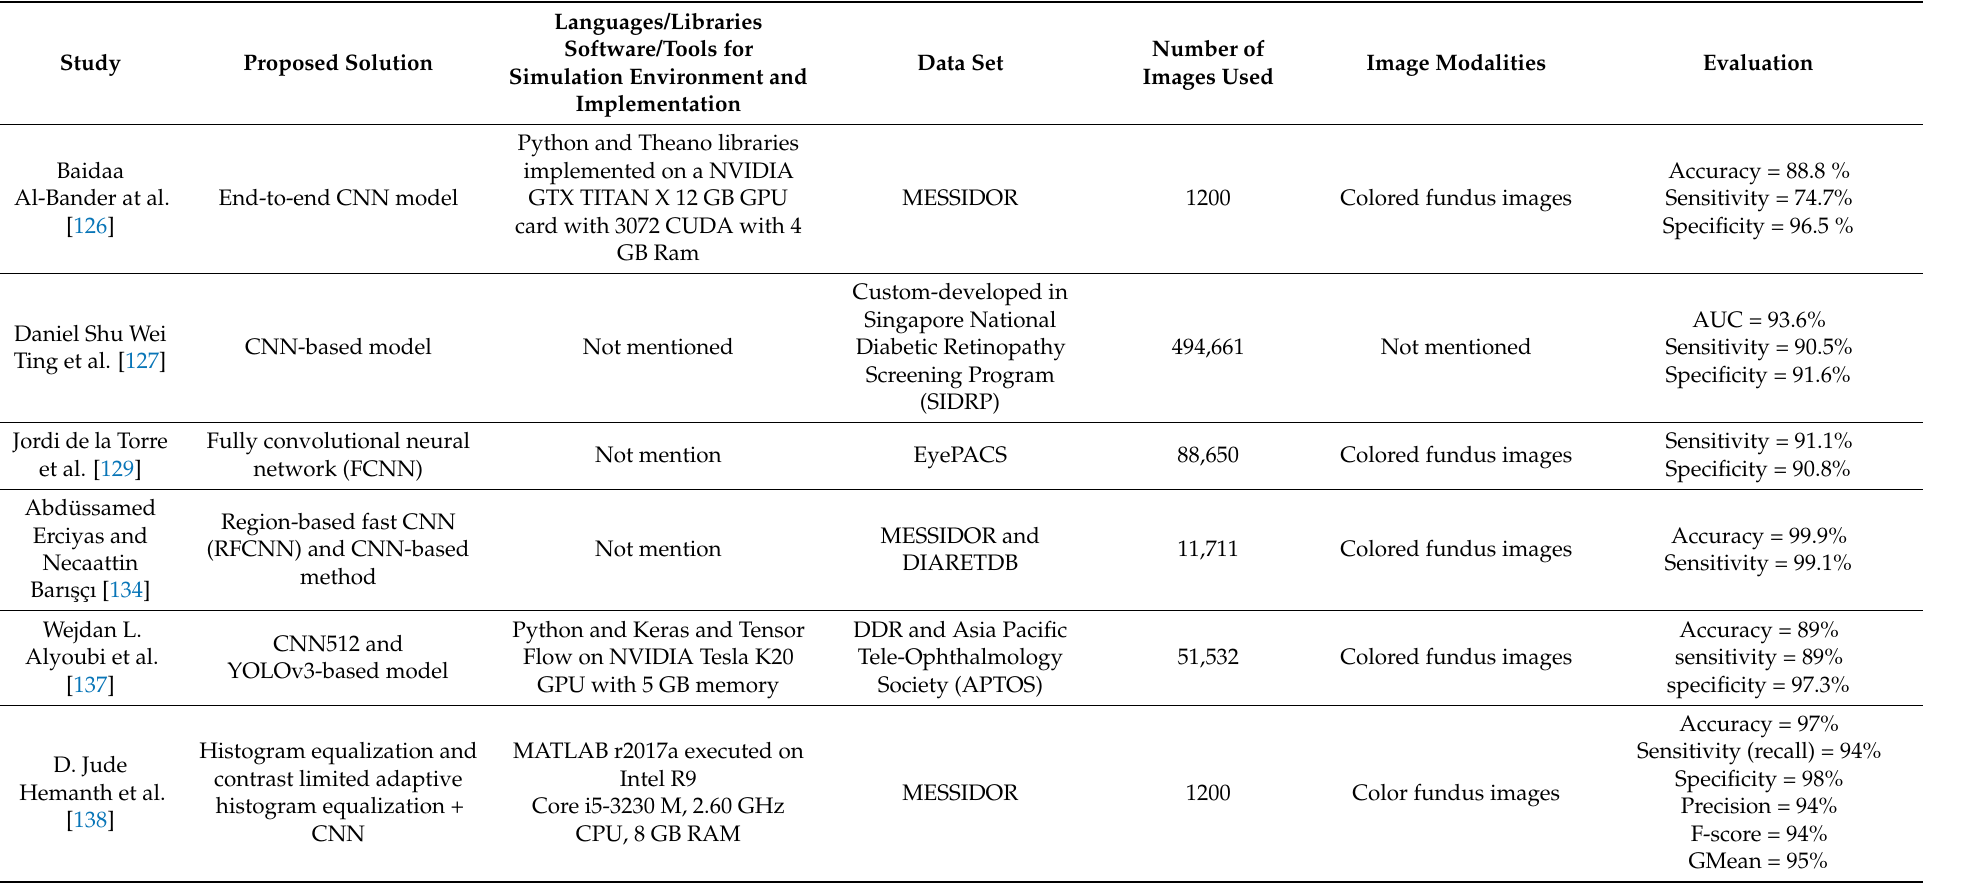
Table 4. Summary of techniques reported for the classification of lesions in DR